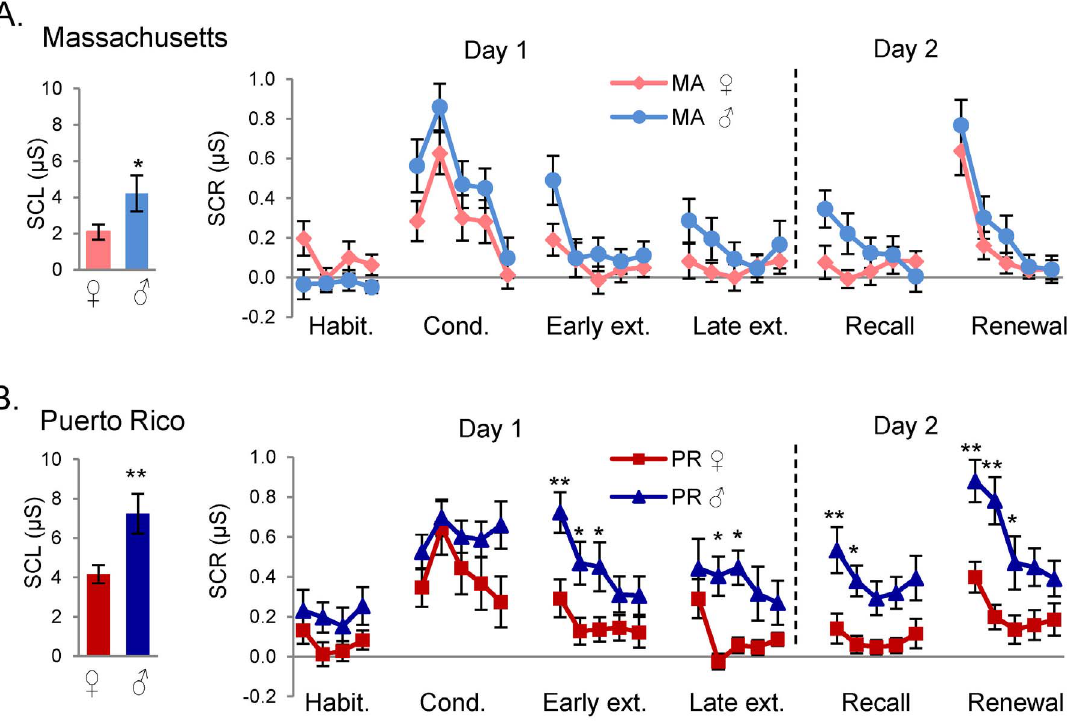
Fig. 3. Sex differences at both sites in skin conductance responses (SCR) to CS + across all experimental phases. A. Responses to CS + in males and females in Massachusetts (MA). B. Responses to CS + in males and females in Puerto Rico (PR). Habit. 5 Habituation, Cond. 5 Conditioning, Ext. 5 Extinction, m S 5 microsiemens. *p , 0.05; **p ,